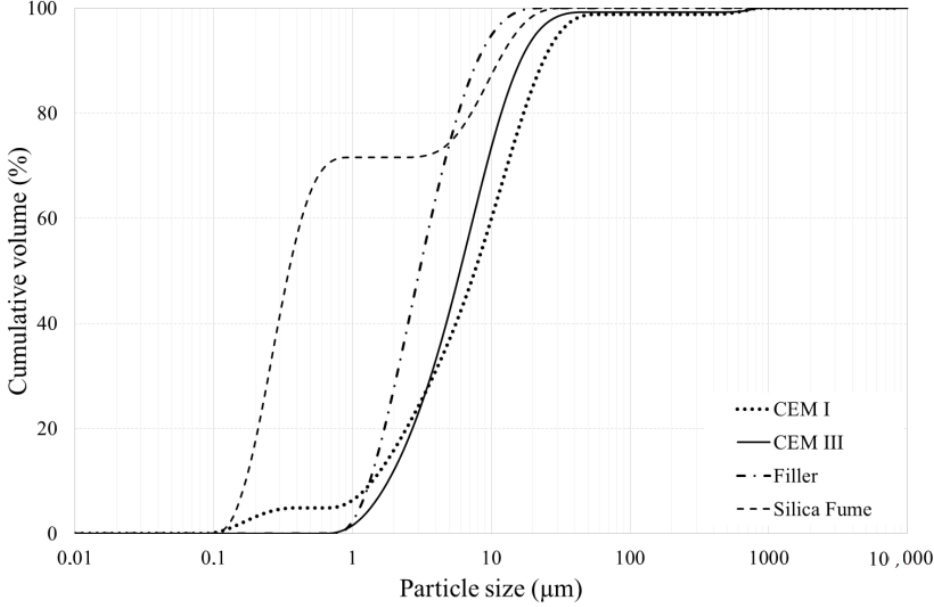
Figure 1. Particle size distribution of CEM I, CEM III, silica fume, and filler as determined by laser